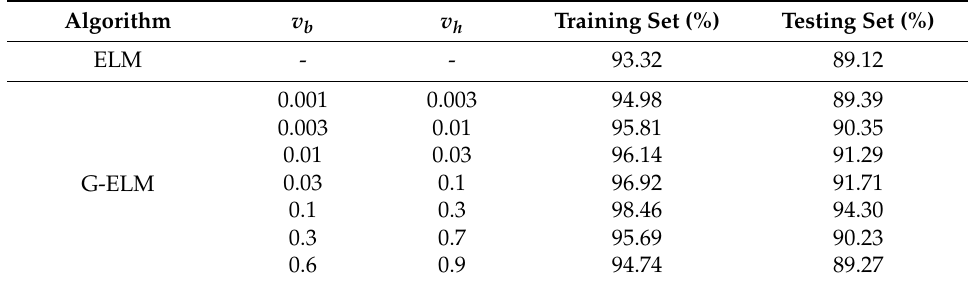
Table 1. Experiments result of ELM (Extreme Learning Machine) and G-ELM (Genetic Extreme Learning